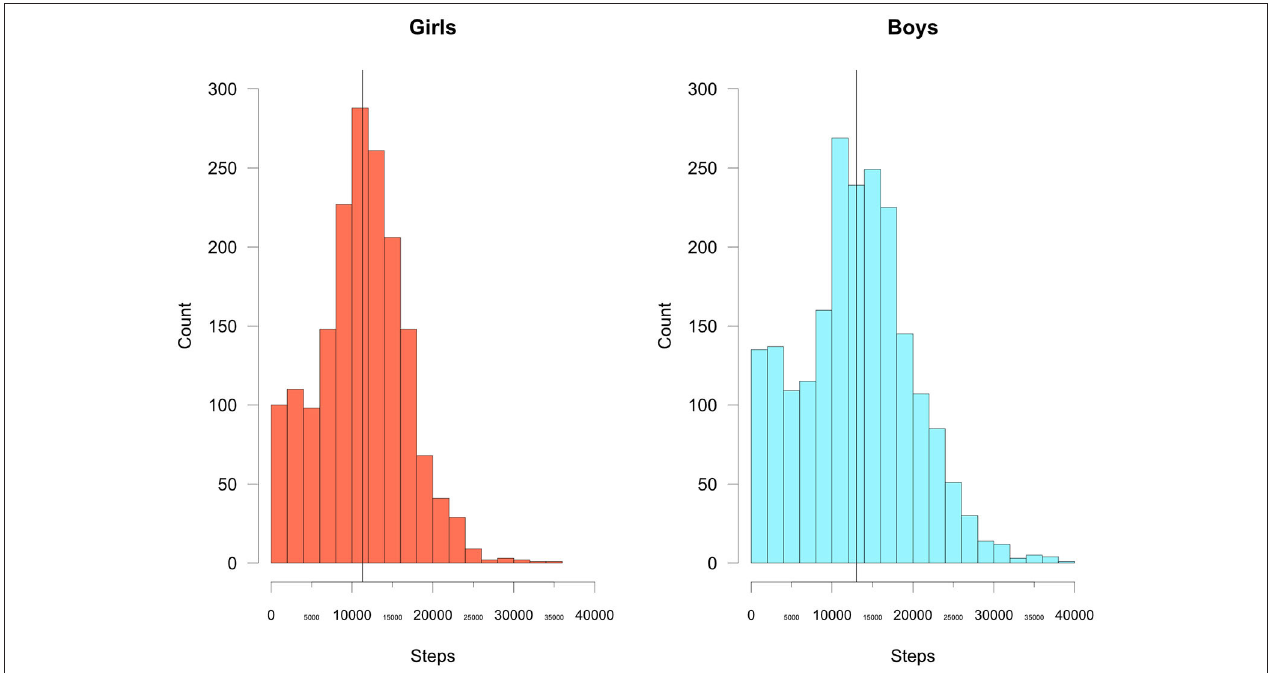
FIGURE 1 | Total daily steps by gender. The vertical black line represents the median